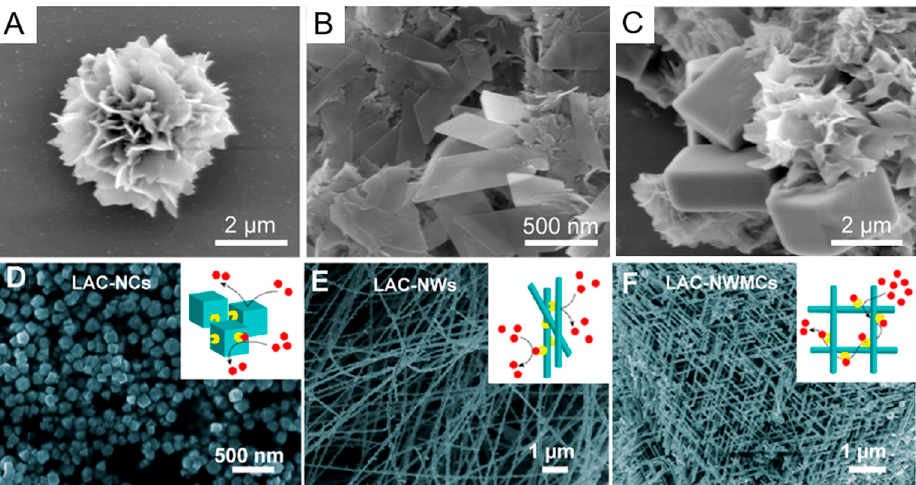
Figure 3. SEM images of CaHPO 4 - α -amylase nanobiocatalysts, ( A ) nanoflowers, ( B ) nanoplates, and ( C ) parallel hexahedrons. Reconstructed with permission from Ref. [17], Copyright (2013) American Chemical Society. SEM images of Cu 2 O–laccase nanobiocatalysts, ( D ) nanocubes, ( E ) nanowires, and ( F ) nanowire mesocrytal, insets are the schematic illustrations of the plausible substrate diffusion pathways for these hybrid materials. Reconstructed with permission from Ref. [16], copyright (2018) American Chemical Society.